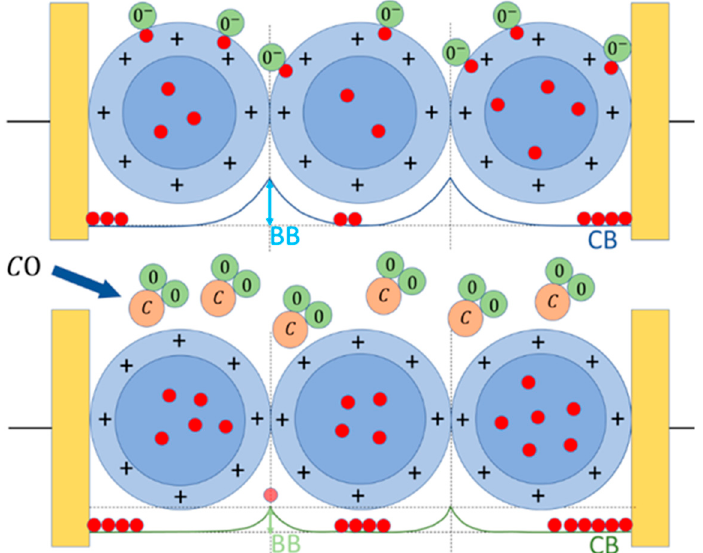
Figure 2. Working principle of an n-type sensor. Upper panel, the sensor grains (blue circles) placed in a reference atmosphere (here, dry air) interacting with the oxygen ions and/or molecules (green circles), which entrap the electrons (red circles) at the sensor grain surface (the external border of the light blue annulus), subtracting them from the grain bulk (blue circle), enlarging the depletion region (light blue annulus) and consequently increasing the grain–grain potential barrier (BB). Lower panel, sensor exposed to CO (C is light brown circles): the oxygen atoms adsorbed at the grain surface reacts with CO, releasing CO 2 in the environment and giving back electrons to the bulk CB, reducing the BB effect.